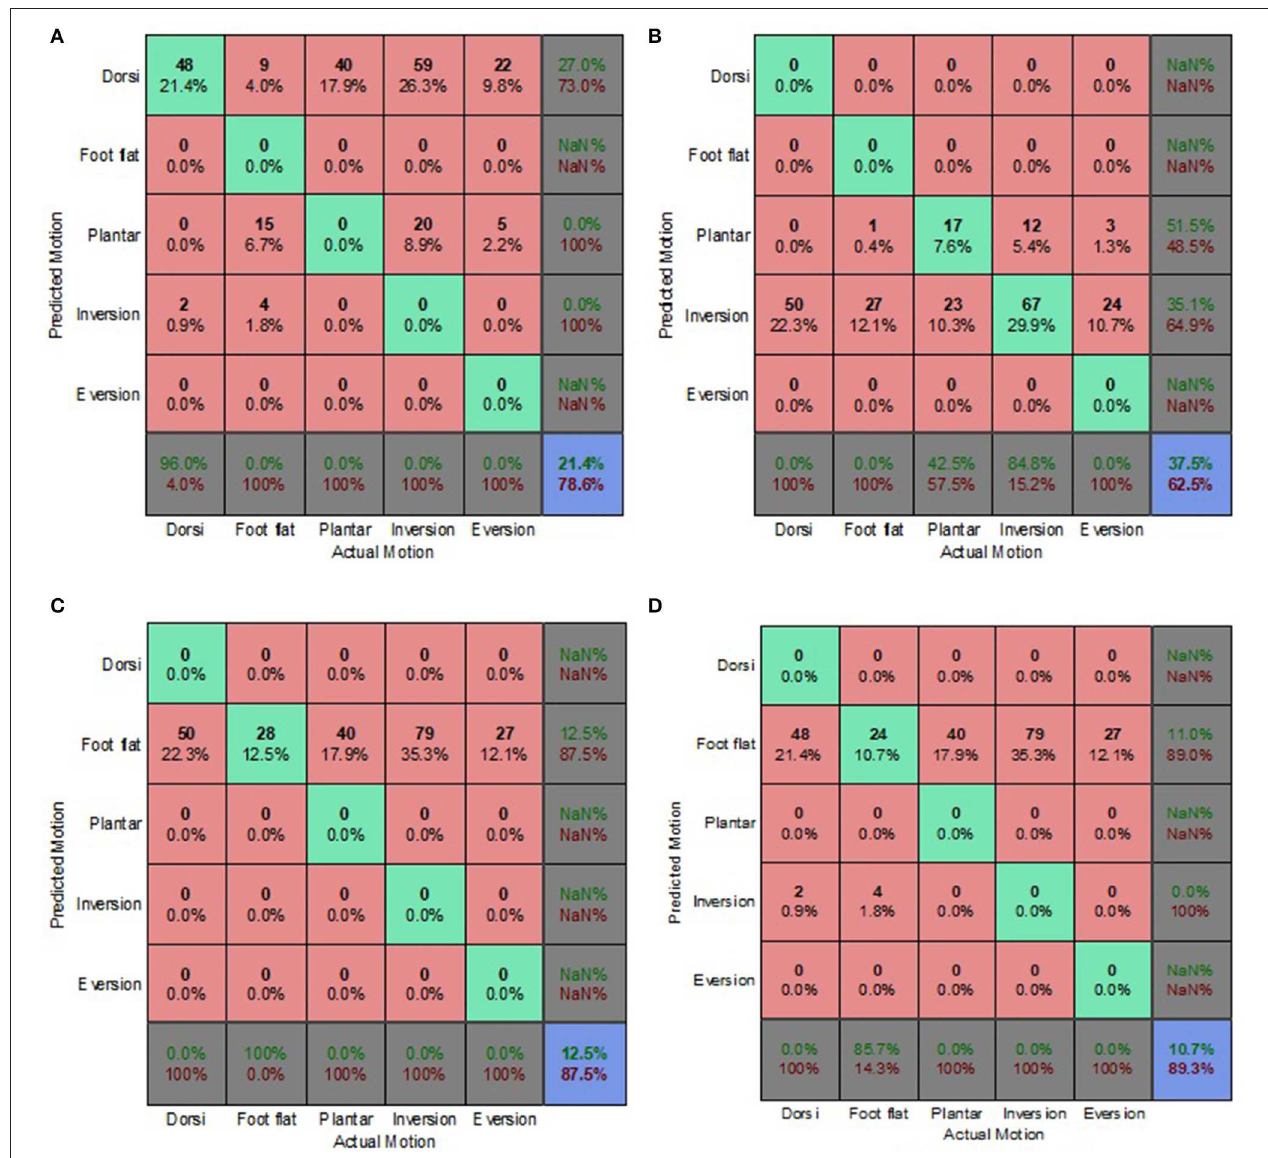
FIGURE 7 | Electrode Shift Condition Combined Data Set—Biased Generic Approach. (A) Tree, (B) LDA, (C) Deterministic, and (D) Voting